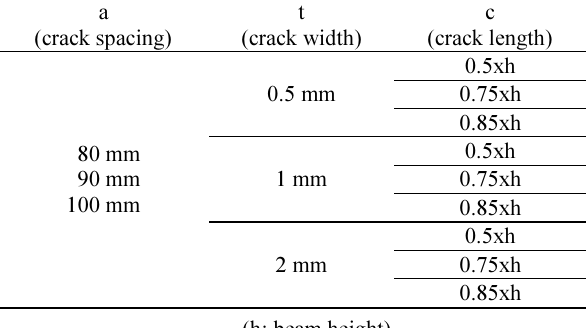
Table 6. Parametric matrix to determine the crack properties